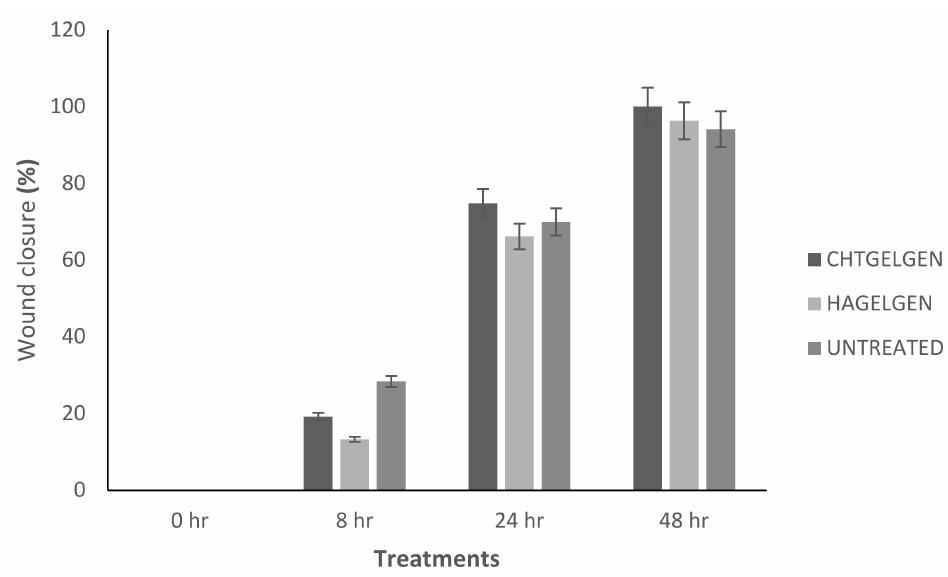
Figure 18. Bar graph showing the percentage wound closure of A172 cells at each interval calculated using NIH ImageJ wound healing tool (n = 3) (SD <